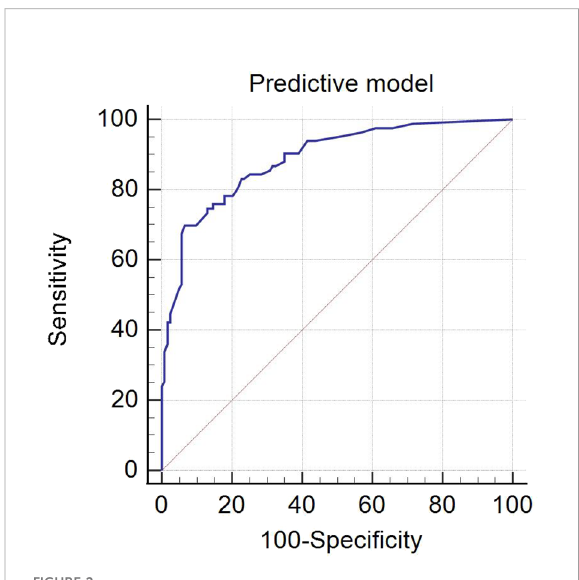
FIGURE 2 The ROC of the predictive model.